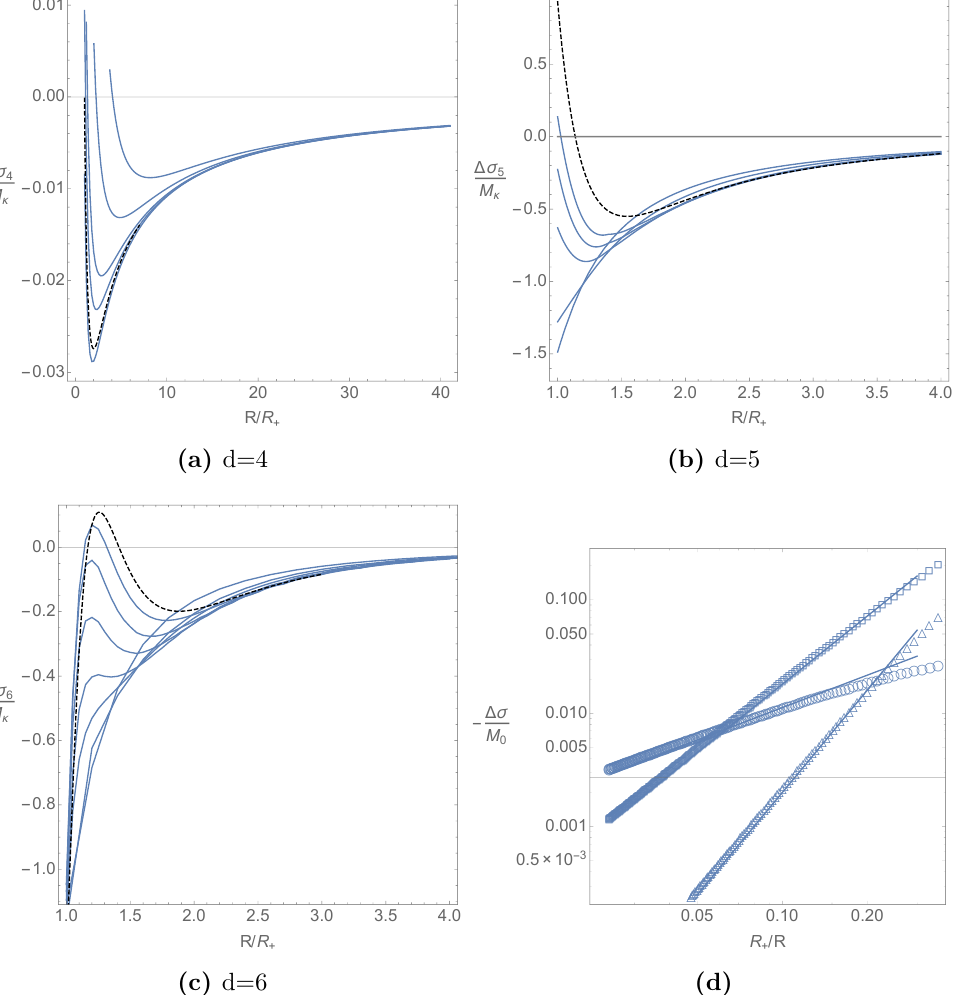
Figure 9. In (a){(c), we plot the (cid:12)nite piece of the entanglement entropies, de(cid:12)ned in (5.17), divided by the mass parameter M (cid:20) for a given R (cid:0) . As can be seen, far from the black hole, all entanglement entropies agree. In (a), the curves correspond to R (cid:0) =R + = 0, .2, .4, .5, .8, 1.0 (top to bottom). In (b), R (cid:0) =R + = 0, .3, .5, .7, .8, 1.0 (bottom to top). Finally, (c) is the six dimensional case with R (cid:0) =R + =0, .4, .5, .6, .7, .8, .9, 1.0 (bottom to top). In all cases, the result for the extremal boundary black hole is in black and dashed. In (d), we show a log-log plot of the asymptotic part of the entanglement entropies as a function of R + =R . These are linear ( (cid:13) ), quadratic ( (cid:3) ), and cubic ( 4 )for d = 4 ; 5 ; 6